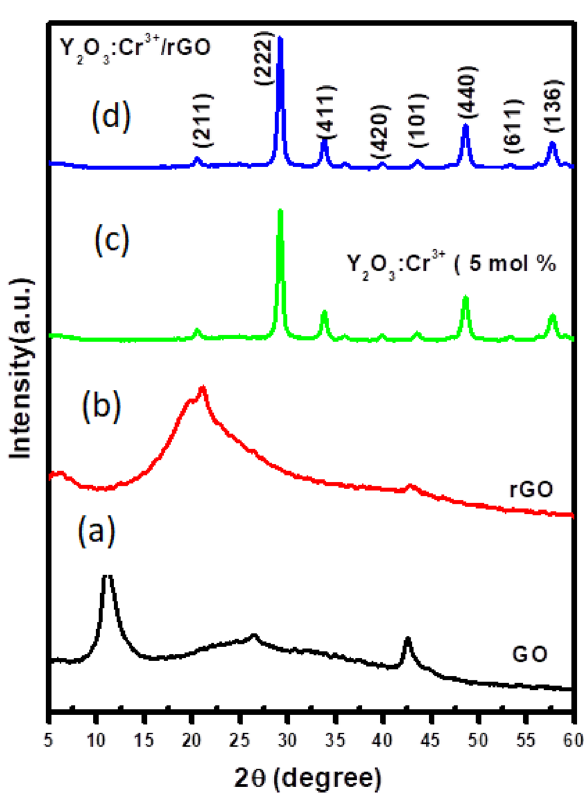
Figure 1. PXRD patterns of ( a ) GO ( b ) rGO NCs ( c ) Y 2 O 3 :Cr 3+ NCs( d) rGO-Y 2 O 3 :Cr 3+